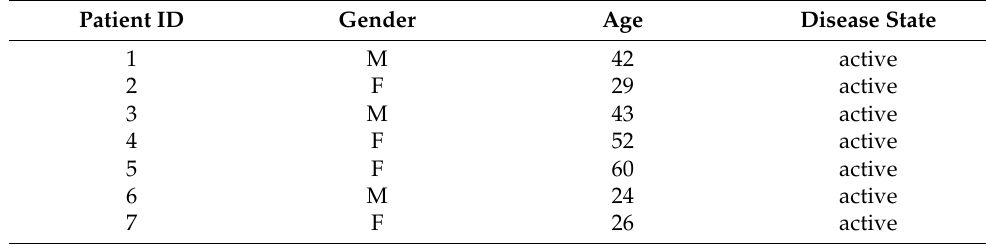
Table 4. General patients